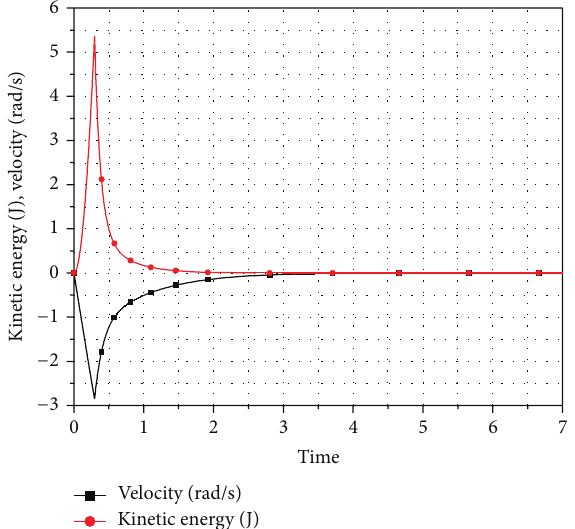
Figure 6: The velocity and kinetic energy of the pendulum.